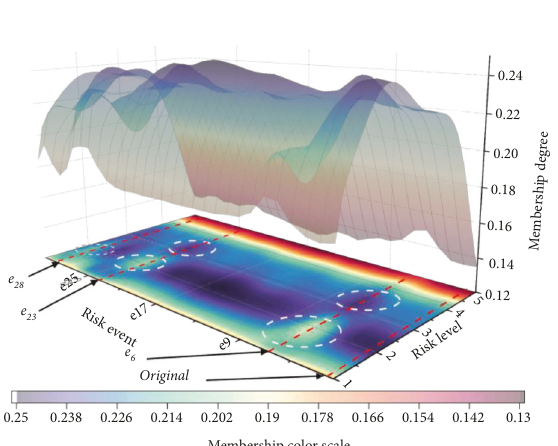
Figure 8: Influence of risk level changes of different events on the overall risk grade of foundation pit.